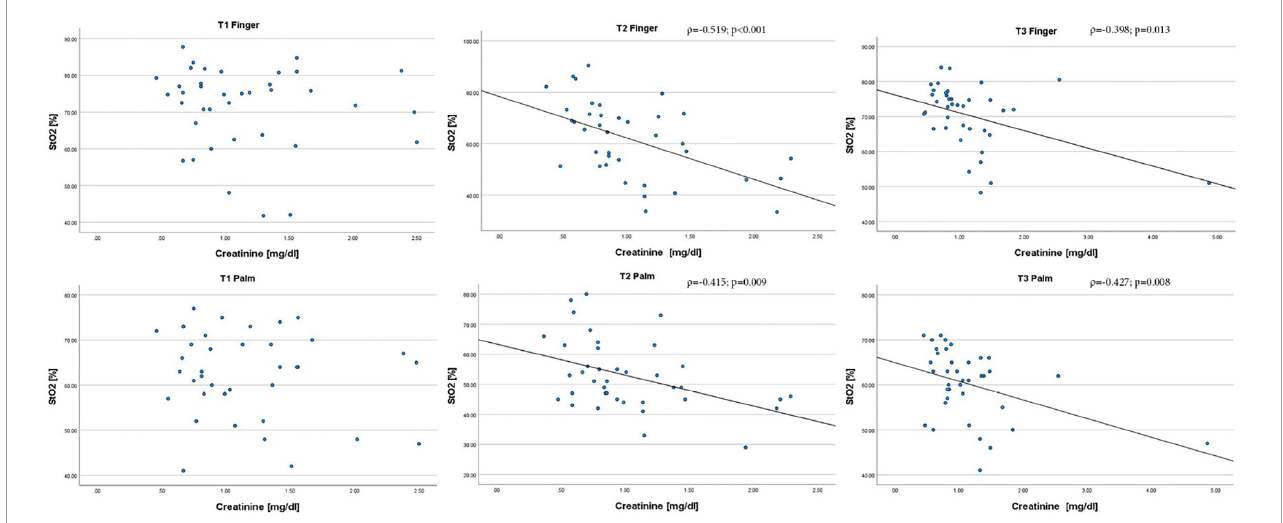
FIGURE4 Scatterplots of the correlation analysis of S t O 2 derived from HSI with creatinine levels at different timepoints and measurement sites; HSI parameters and creatinine levels were taken at three different timepoints: before valve replacement (T1), after valve replacement (T2) and 3 days after valve replacement (T3). Creatinine levels are shown on the x-axis and the corresponding S t O 2 values are shown on the y-axis. S t O 2 is given in%, creatinine is given in mg/dl. Spearman correlation was used. S t O 2 , tissue oxygenation; ρ , coefficient of